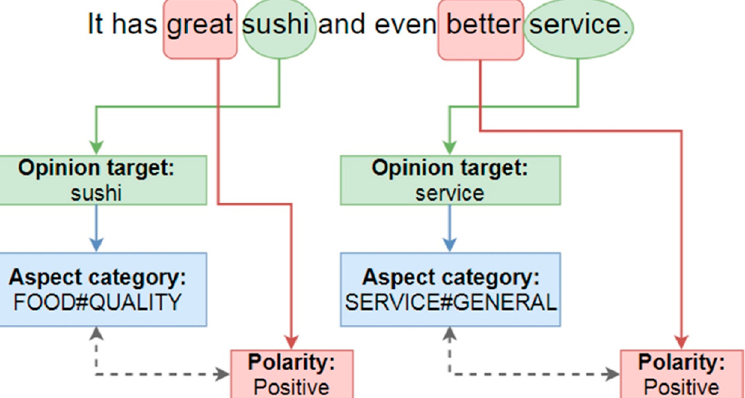
Figure 4. Aspect-based sentiment analysis. Reprinted with permission from Ref. [29], Copyright 2019,